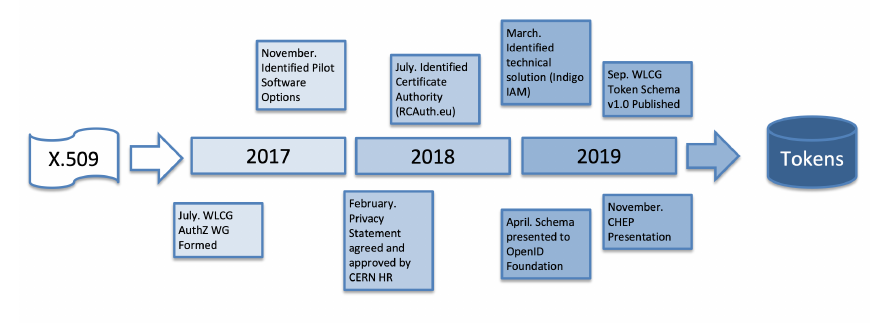
Figure 1. Key milestones achieved between 2017 and 2019 towards a token based authorisation scheme. Note, it is not implied that the final goal has been reached; much additional e ff ort is required to fully transition from X.509 to tokens.